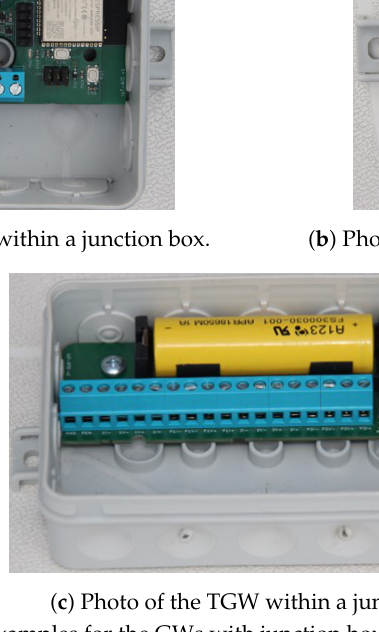
Figure 10. Enclosure examples for the GWs with junction